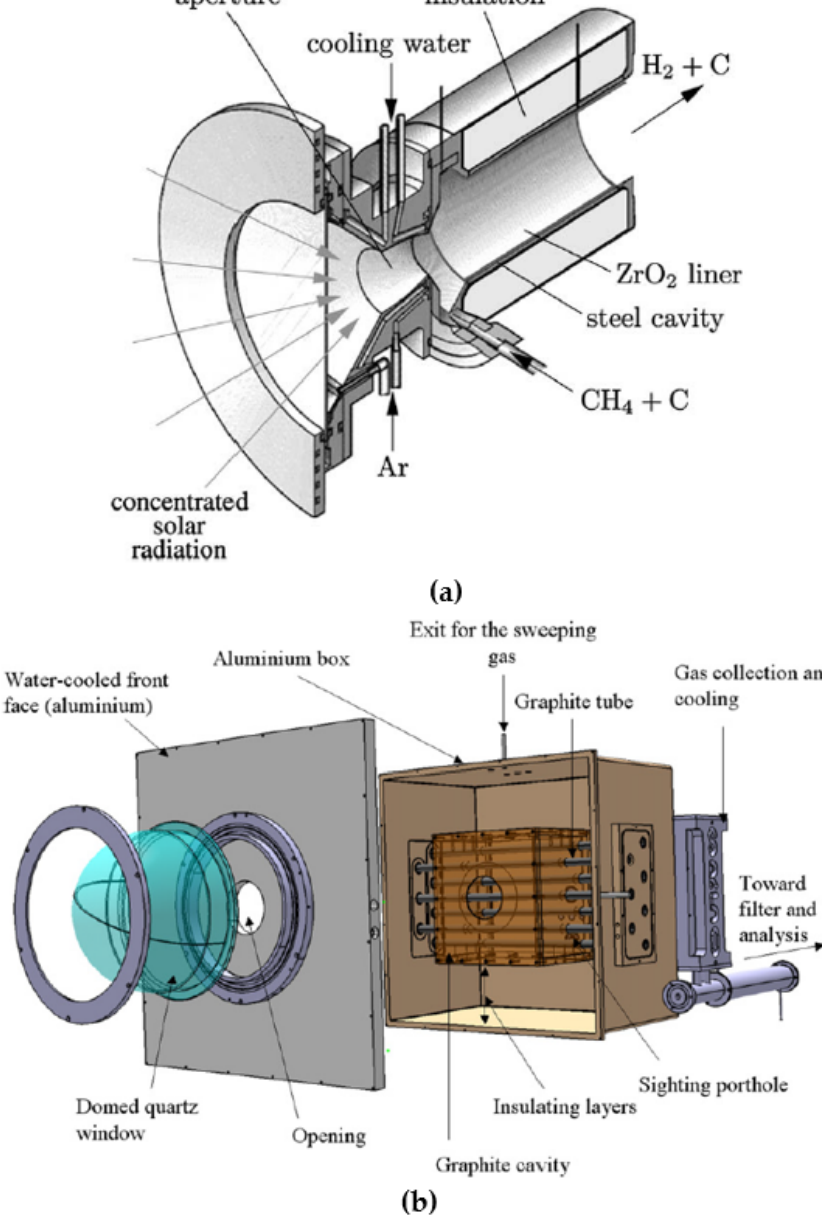
Figure 1. Directly- vs. indirectly-irradiated solar reactors used for methane pyrolysis: ( a ) 5 kW directly-irradiated reactor (Copied from Ref. [108] with Elsevier permission), ( b ) 50 kW indirectly-irradiated reactor (Copied from Ref. [102] with Elsevier permission).